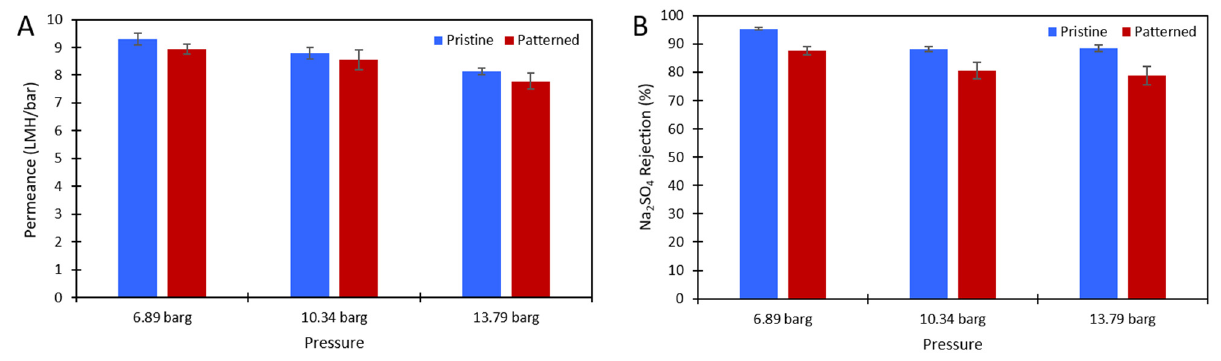
Figure 4. ( A ) The solution permeance (LMH/bar) data and ( B ) Na 2 SO 4 rejection data for the 2000 ppm Na 2 SO 4 feed. Blue is the pristine membrane, and red is the patterned membrane. The error bars represent one standard deviation among at least three membrane samples.